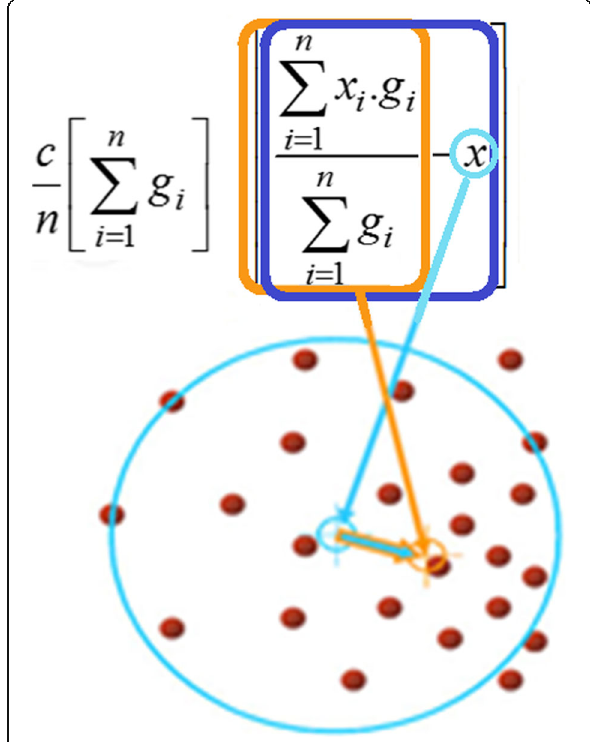
Fig. 7 Movement of target vector toward the dense points during gradient of PDF